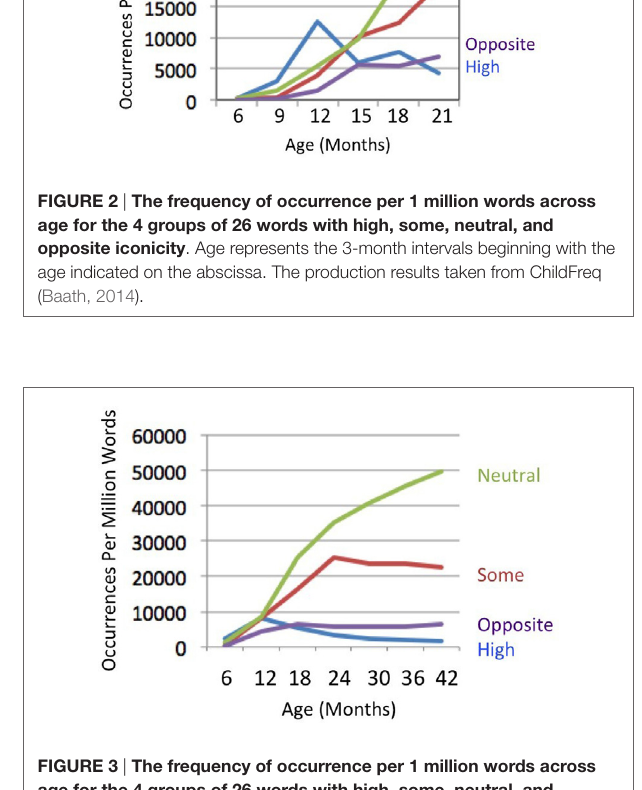
FigUre 3 | The frequency of occurrence per 1 million words across age for the 4 groups of 26 words with high, some, neutral, and opposite iconicity . Age represents the 6-month intervals beginning with the age indicated on the abscissa. The production results taken from ChildFreq (Baath, 2014).